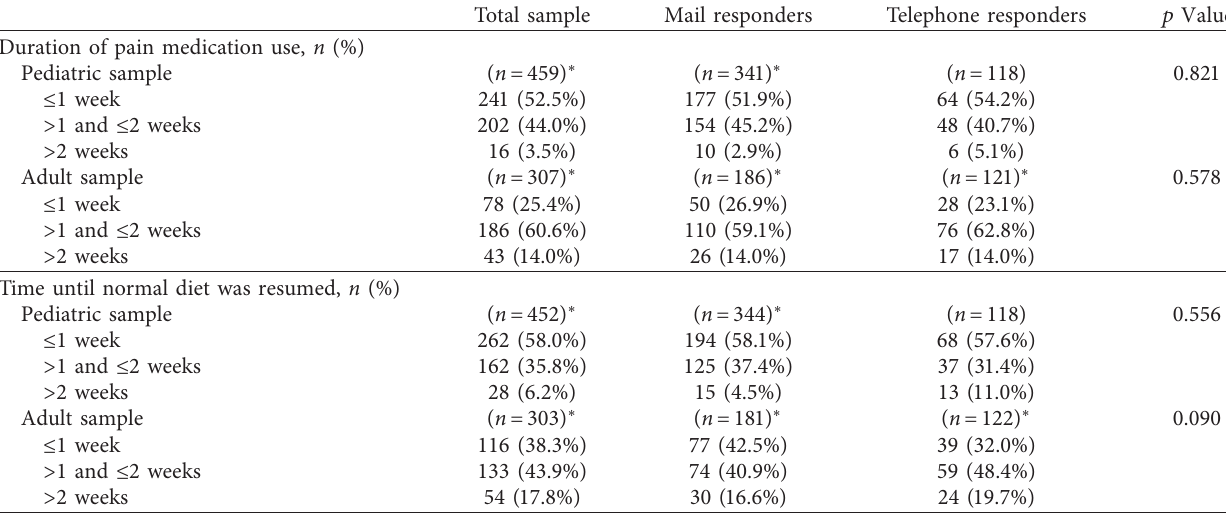
Table 3: Use of pain medication and time normal diet was resumed for mail and telephone respondents by age group. Total sample Mail responders Telephone responders